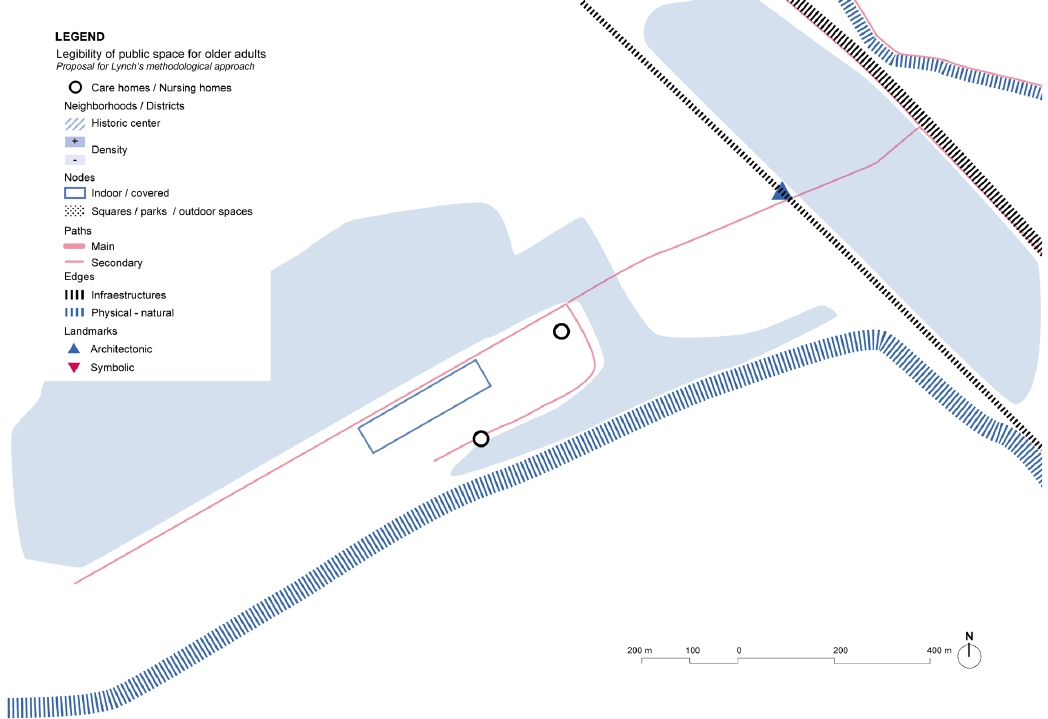
Figure 7. Harmonia Village’s surroundings’ scheme based on Lynch’s theory. Source: Own elaboration.